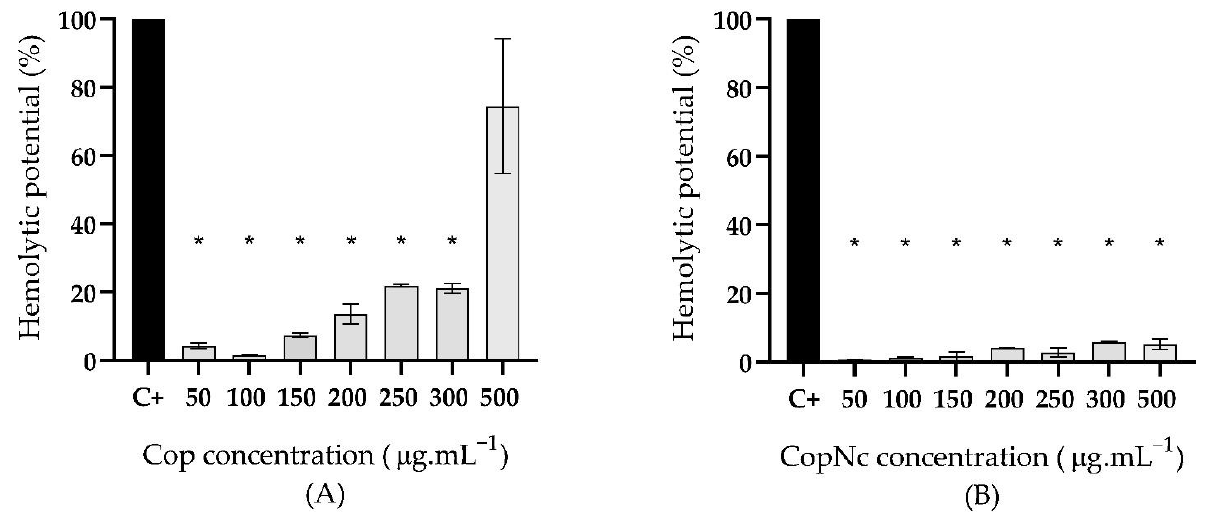
Figure 3. The hemolytic potential of free copaiba oil (Cop) ( A ) and copaiba oil-loaded nanocapsules (CopNc) ( B ) at concentrations from 50 to 500 μg ·mL −1 based on the theoretical amount of Cop. C+: positive control; *: p < 0.05.